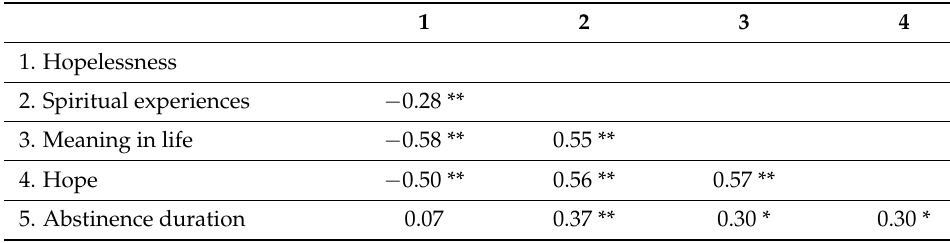
Table 3. Correlation matrix ( n =